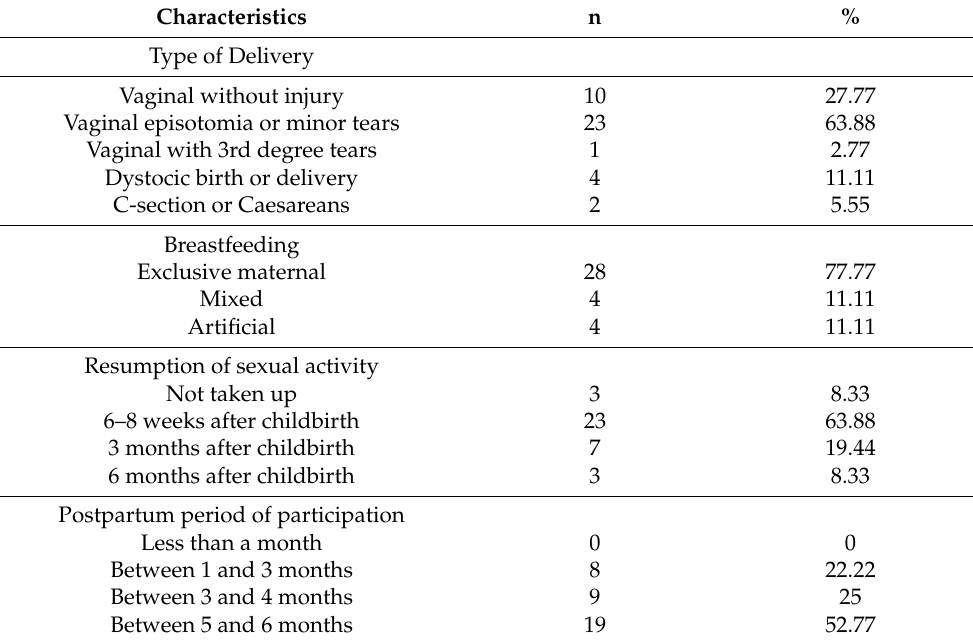
Table 3. Gynecological and obstetric data, characteristics of the postpartum period, and restart of relations.